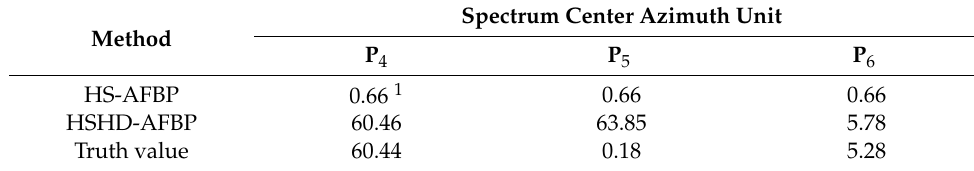
Table 3. The spectrum center azimuth